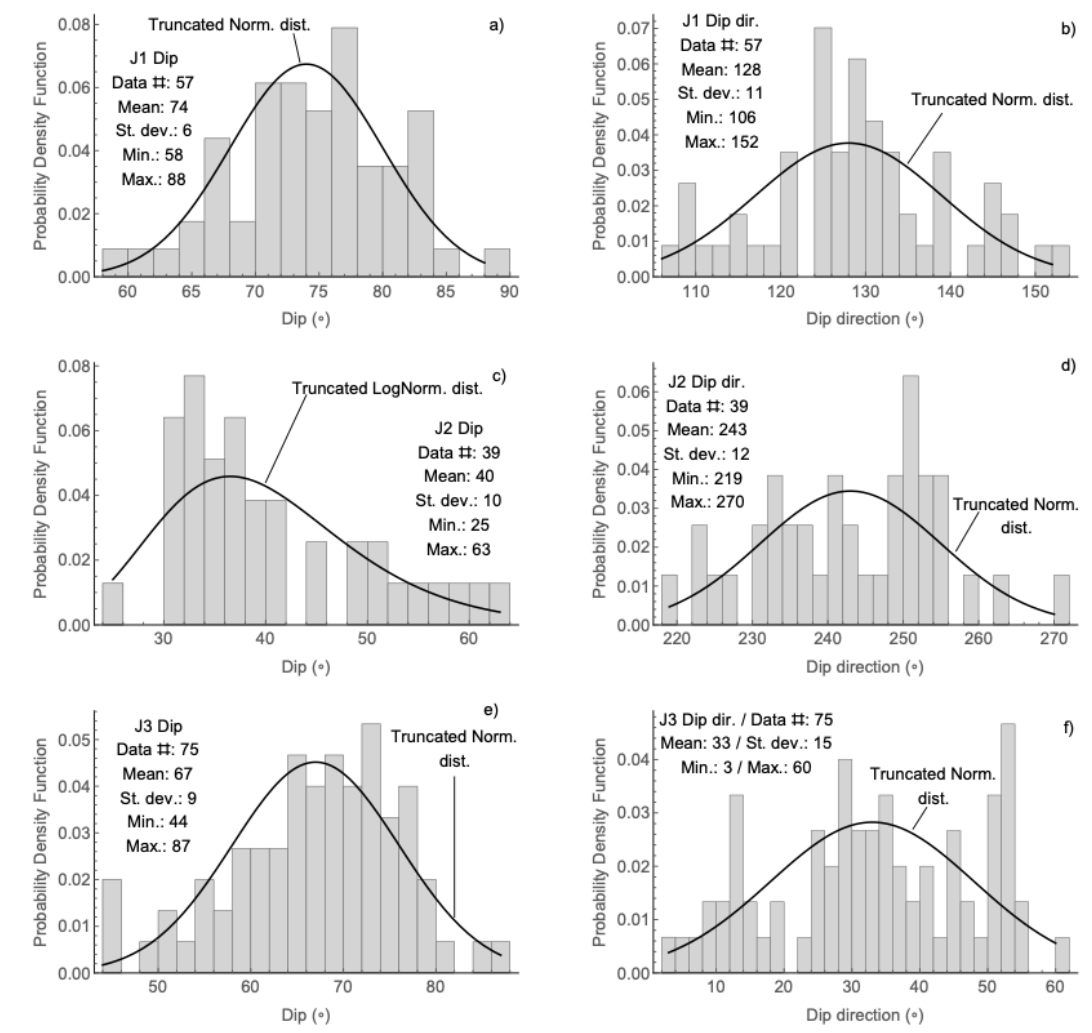
Figure 9. Probability density histograms of joint set orientation and fitted probability density function (PDF). J1 dip ( a ) and dip direction ( b ), J2 dip ( c ) and dip direction ( d ), J3 dip ( e ), and dip direction ( f ). Table 2. Pearson’s 2 probability values for the goodness of fit tests for measured orientation PDF adopted. Values over 0.05 are considered an adequate fit. Joint Set Dip Dist. Fit Dip Direction Dist. Fit